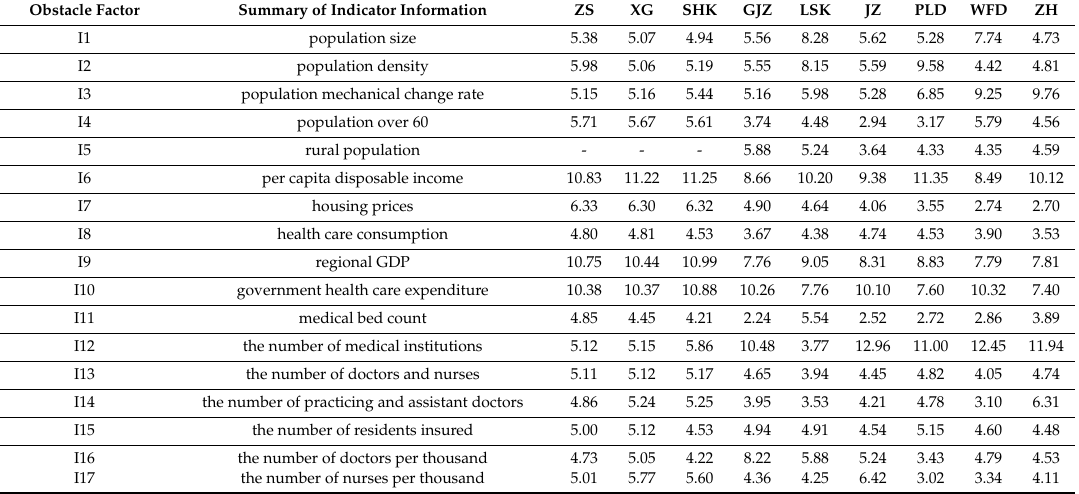
Table 5. Factor of each